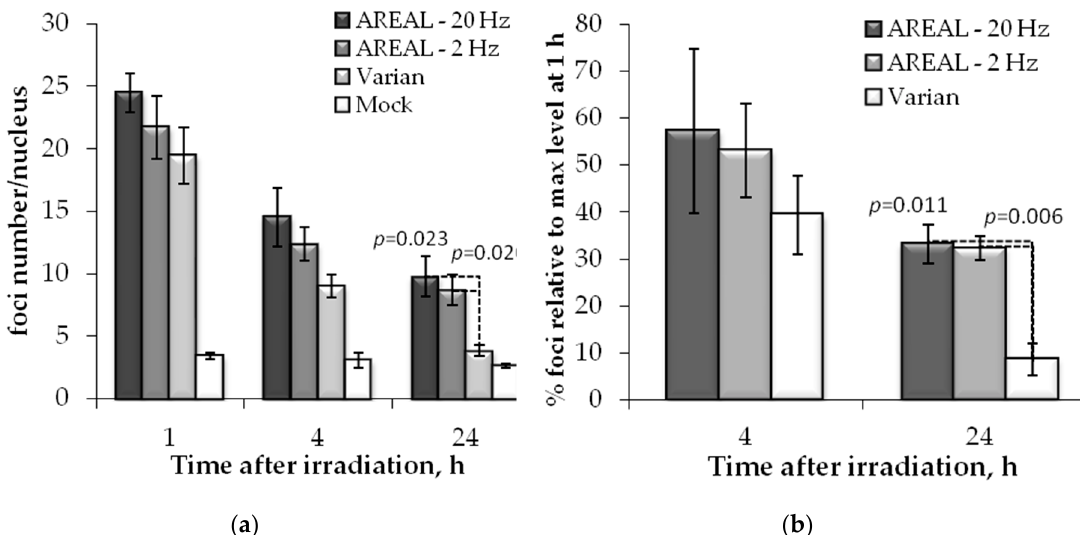
Figure 3. Post-irradiation changes of the 53BP1 foci in Hela cells, irradiated on AREAL (ultrashort pulsed 3.6 MeV electron beams) and Varian (quasi-continuous 4.0 MeV electron beams) accelerators at a 1000 mGy dose: ( a ) number of foci in a cell nucleus; ( b ) foci % in relation to the value at 1 h post-irradiation. Mean values derived from at least three independent experiments are shown. Error bars show SE. Statistical significance was tested using the Student t-test. p values < 0.05 are shown.